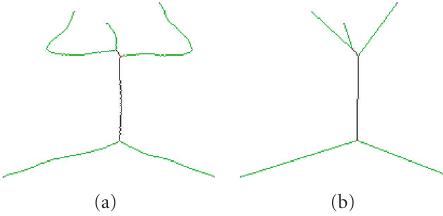
Figure 3: Extracted skeleton and topology